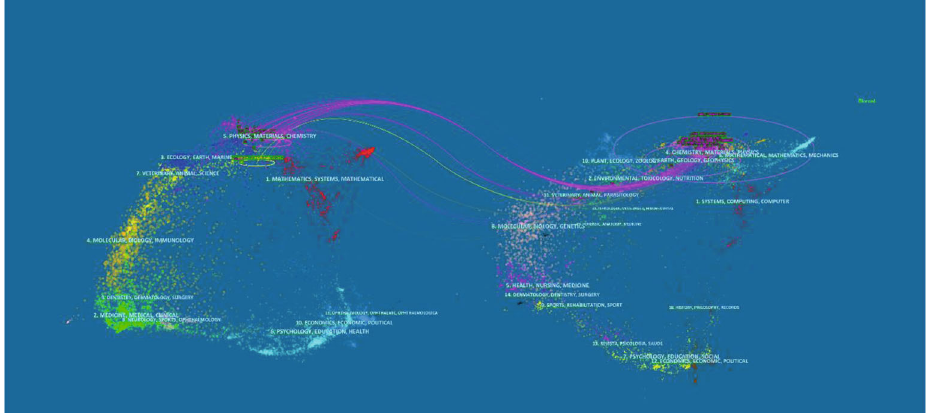
Figure 2: Dual map of published papers and citations related to PI-based materials for separator